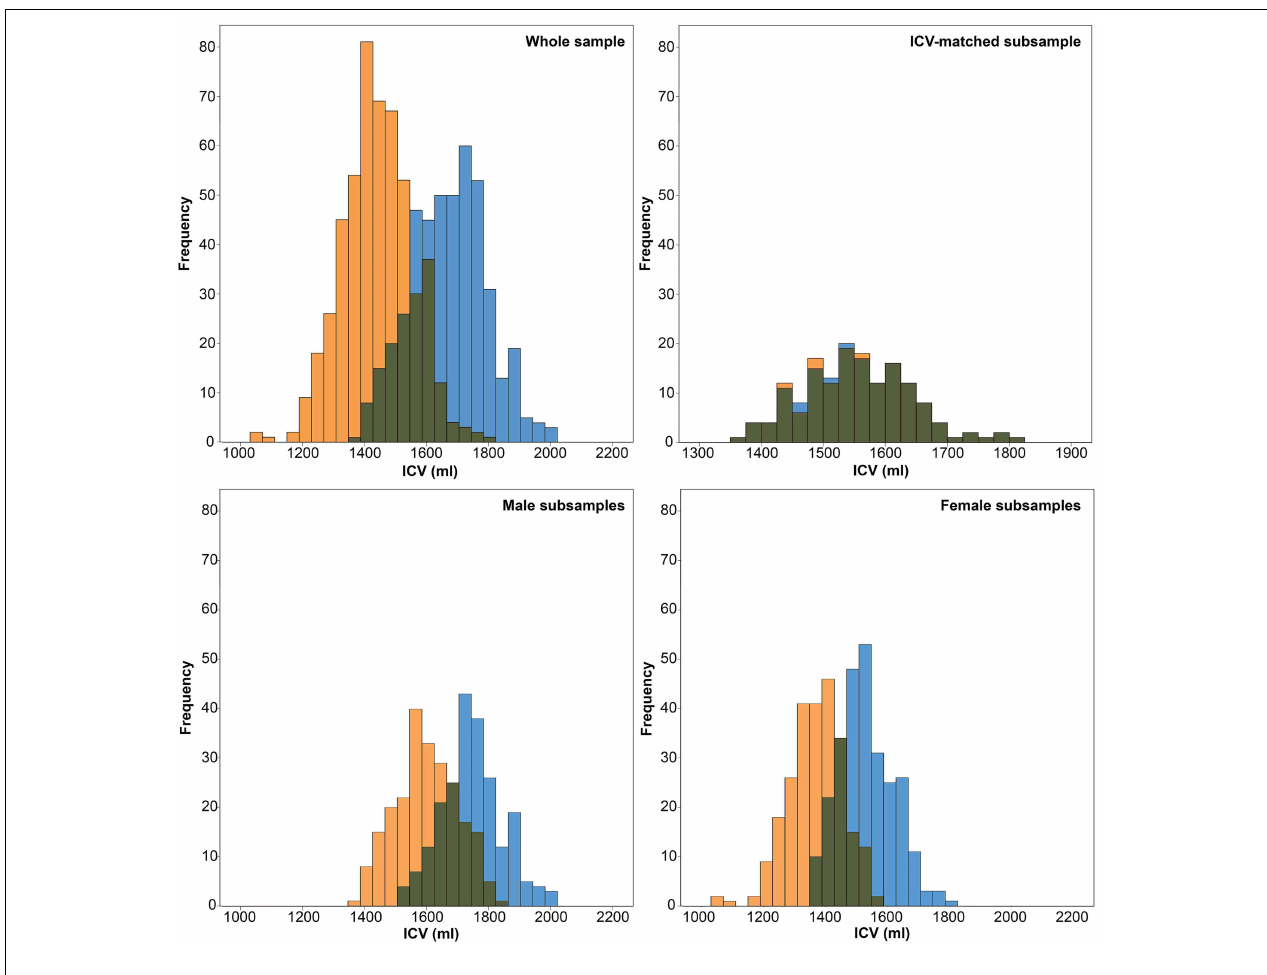
FIGURE 2 | Histograms of intracranial volumes (ICV). Top left : The frequency of ICV in the whole sample for women (orange) and men (blue). Top right : The frequency of ICV in the ICV-matched subsample for women (orange) and men (blue). Bottom left : The